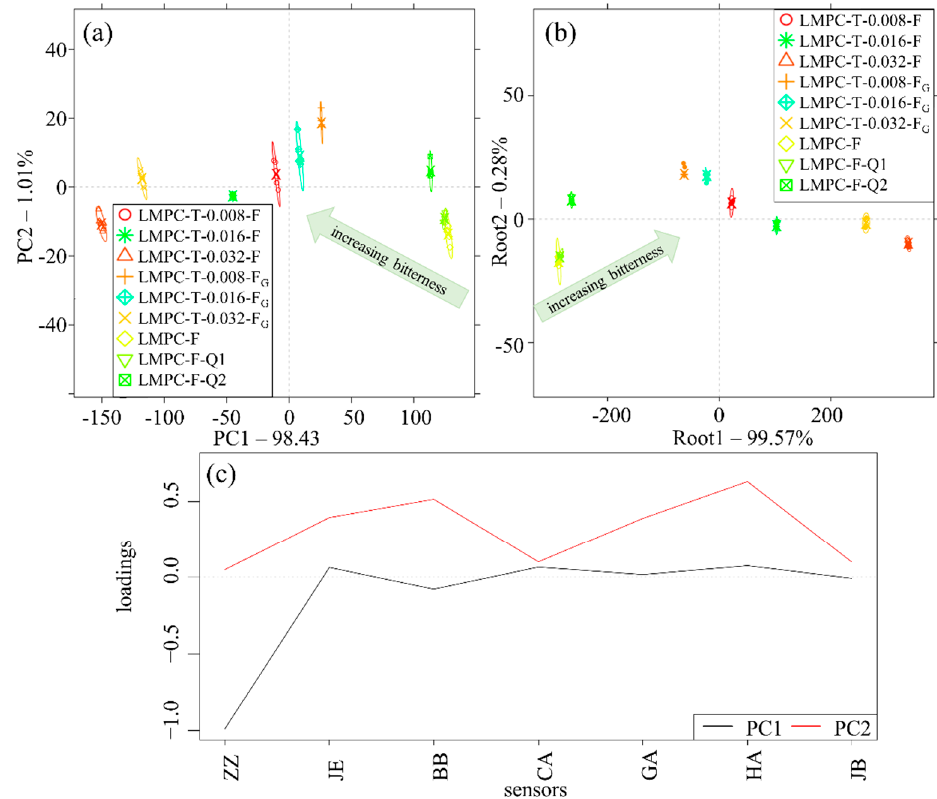
Figure 4. PCA score plot ( a ), LDA score plot ( b ) and PCA loading plots ( c ), which were developed based on the results of the E-tongue with aqueous solutions of LMPC-T-0.008-F, LMPC-T-0.016-F, LMPC-T-0.032-F, LMPC-T-0.008-F G , LMPC-T-0.016-F G , LMPC-T-0.032-F G , LMPC, LMPC_Q1 and LMPC_Q2 (ellipses show the 95% confidence intervals, filled dots on the LDA figure represent the observations used in the cross-validation). LMPC: liquid milk protein concentrate, T: trypsin, F: fer- mentation with lactic acid bacteria in the absence of glucose, F G : fermentation with lactic acid bac- teria in the presence of glucose.